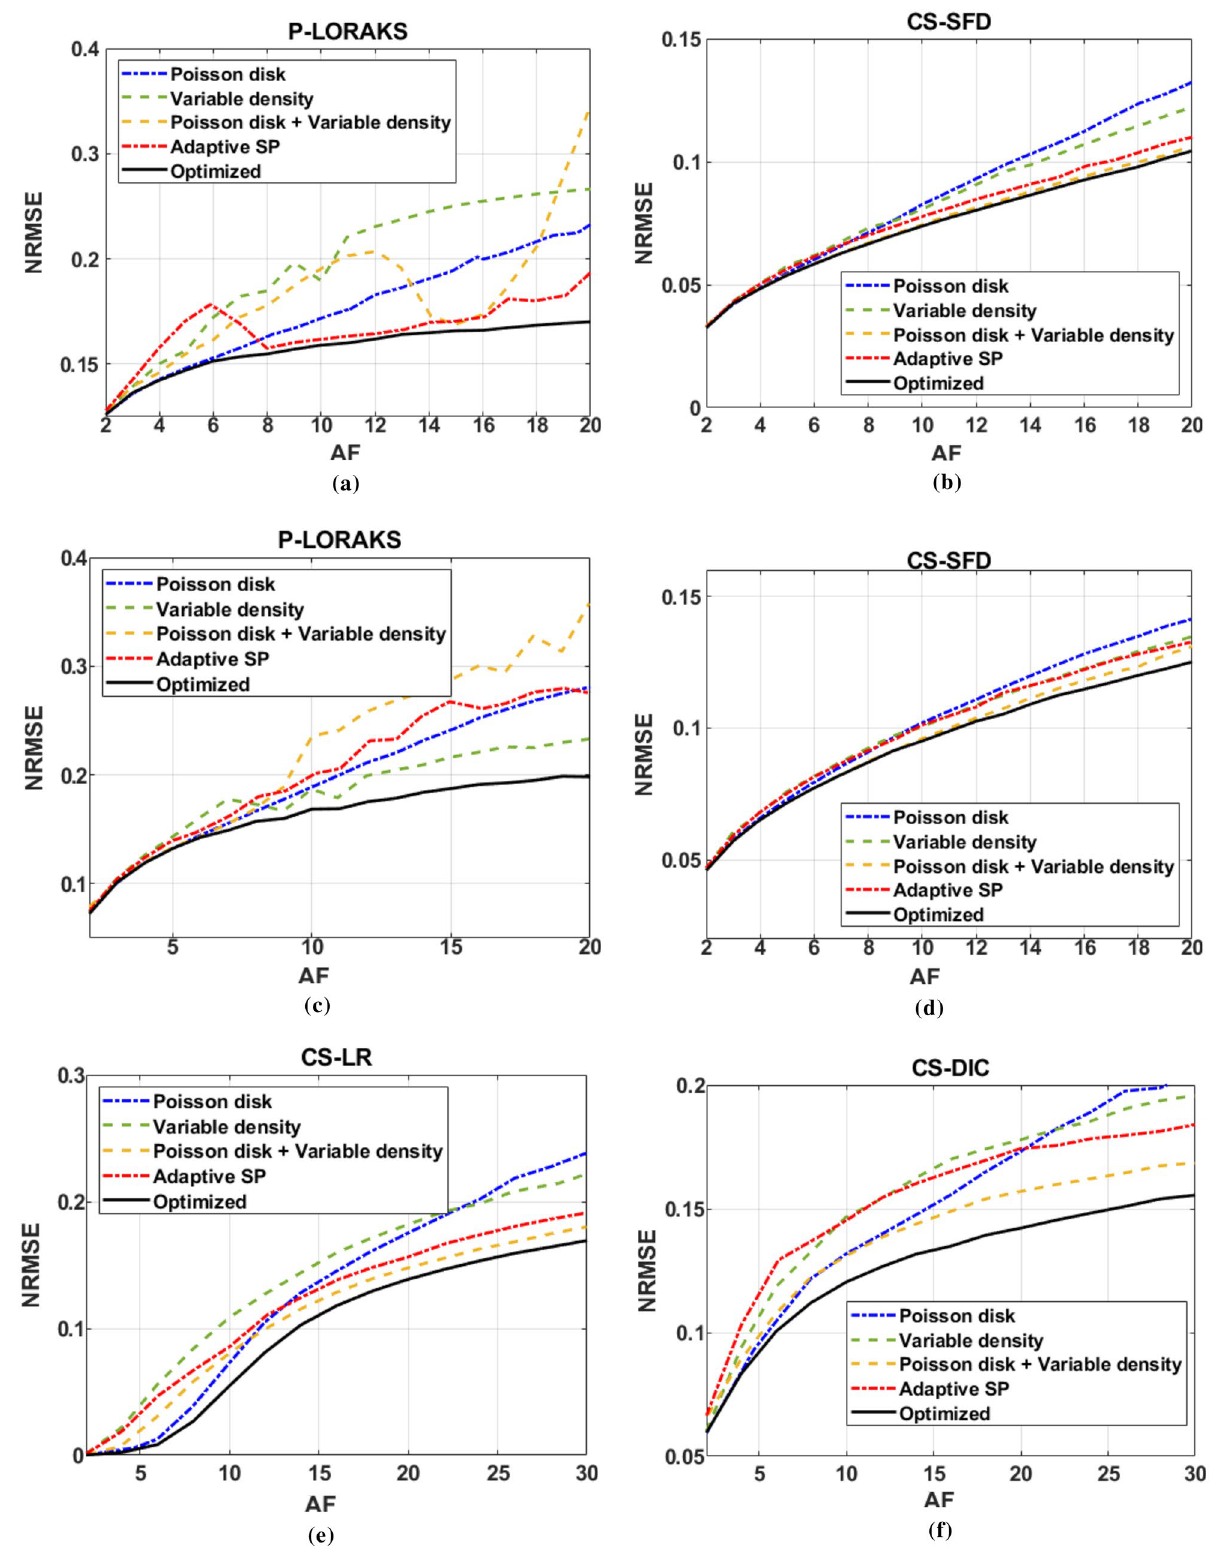
Figure 5. NRMSE (lower is better): ( a ) for P-LORAKS and ( b ) CS-SFD for T 2 - brain dataset, ( c ) for P-LORAKS and ( d ) CS-SFD for T 1 ρ - brain , dataset, and ( e ) for CS-LR, and ( f ) CS-DIC for T 1 ρ - knee dataset. Variable density, Poisson disk, adaptive SP, and combined variable density with Poisson disk are compared with optimized SP (obtained by BASS) for various